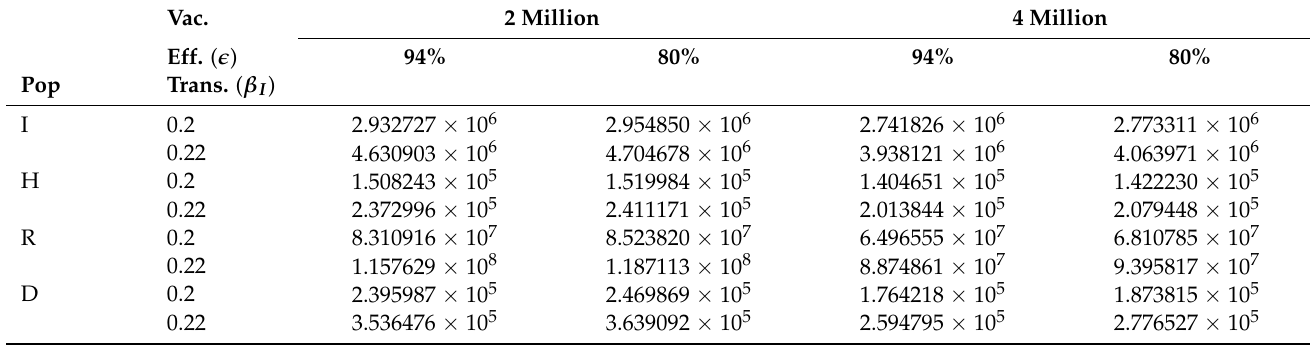
Table 4. Impact of the inoculation rate (Vac.) and the efficacy ( (cid:101) ) of the vaccine on the peak of the infected (I) and hospitalized (H) subpopulations. In addition, on the deaths (D) and recovered (R) cases. In these scenarios, the infectiousness of the asymptomatic individuals relative to symptomatic is 75% ( β A = β I ), and the percentage of infections that are asymptomatic is